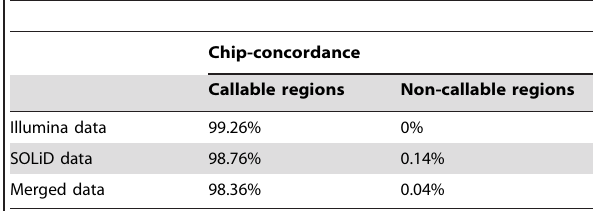
Table 3. Chip-concordance of callable and non-callable